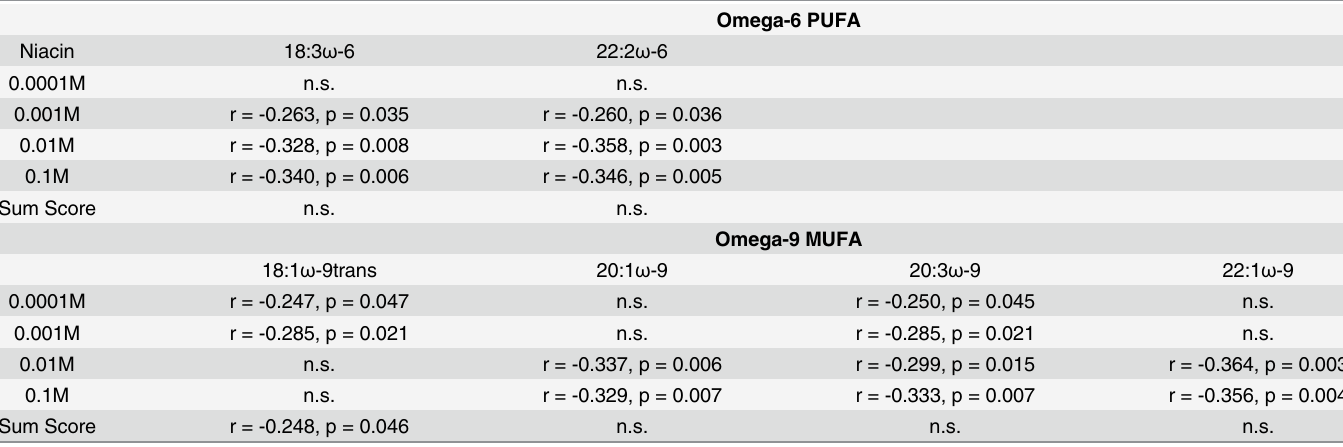
Table 4. Correlation analysis between niacin sensitivity and membrane fatty acid levels between all UHR